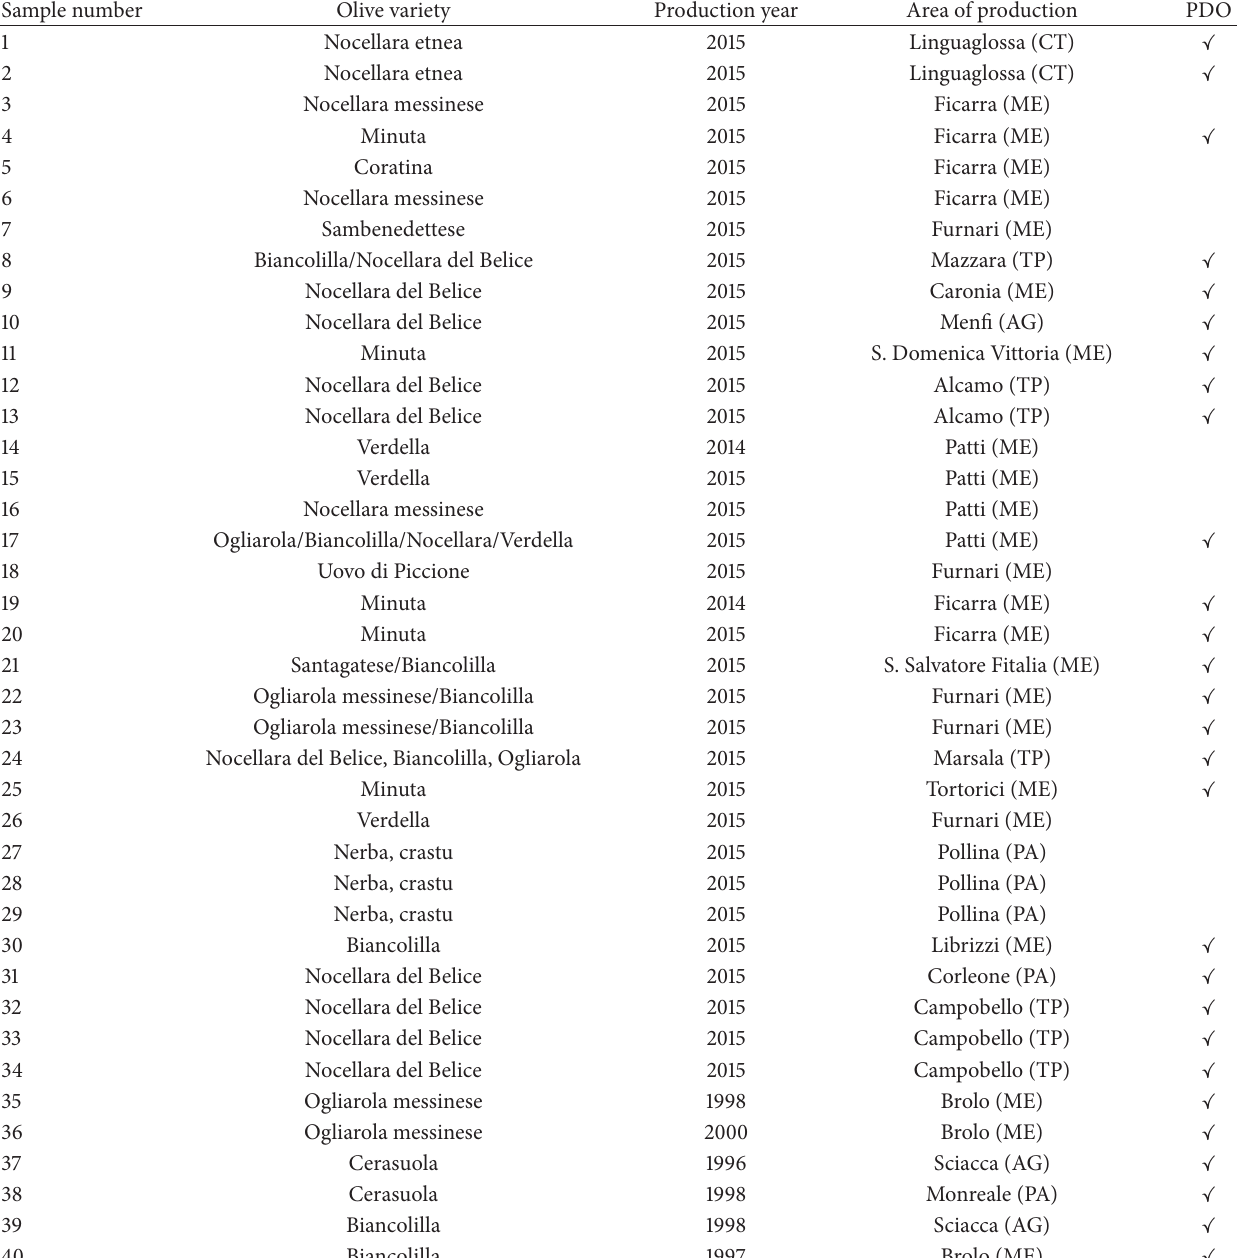
Table 1: List of extra virgin olive oil (EVOO) samples with indication of olive variety and place of origin, year of production, and “protected designation of origin” (PDO)